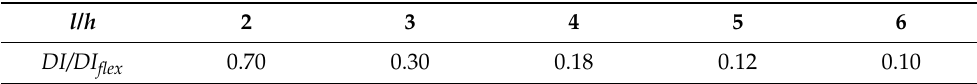
Table 2. DI/DI flex to l/h for URM buildings up to three stories, timber floor, and f t < 0.15 MPa (after Moric